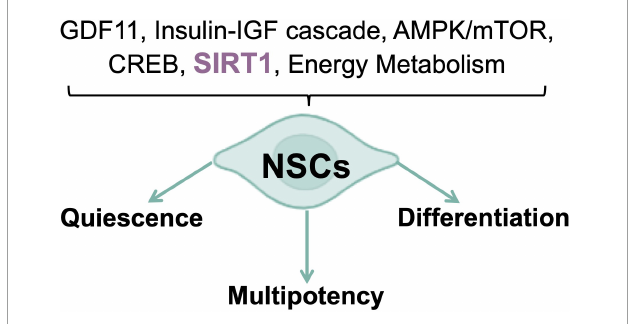
FIGURE1 Nutrient pathways control of NSCs fate. Nutrient sensing and energy metabolism are the major physiological determinants of neurogenic